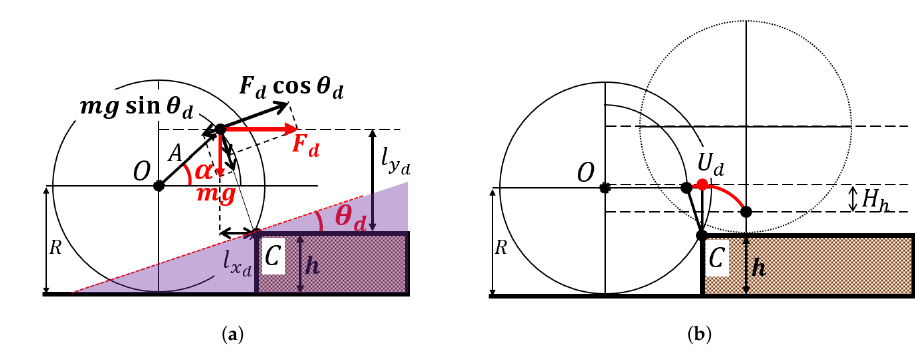
Figure 5. Illustration of axle translation based on α . ( a ) F d in Equation (9); ( b ) U d in Equation (10).